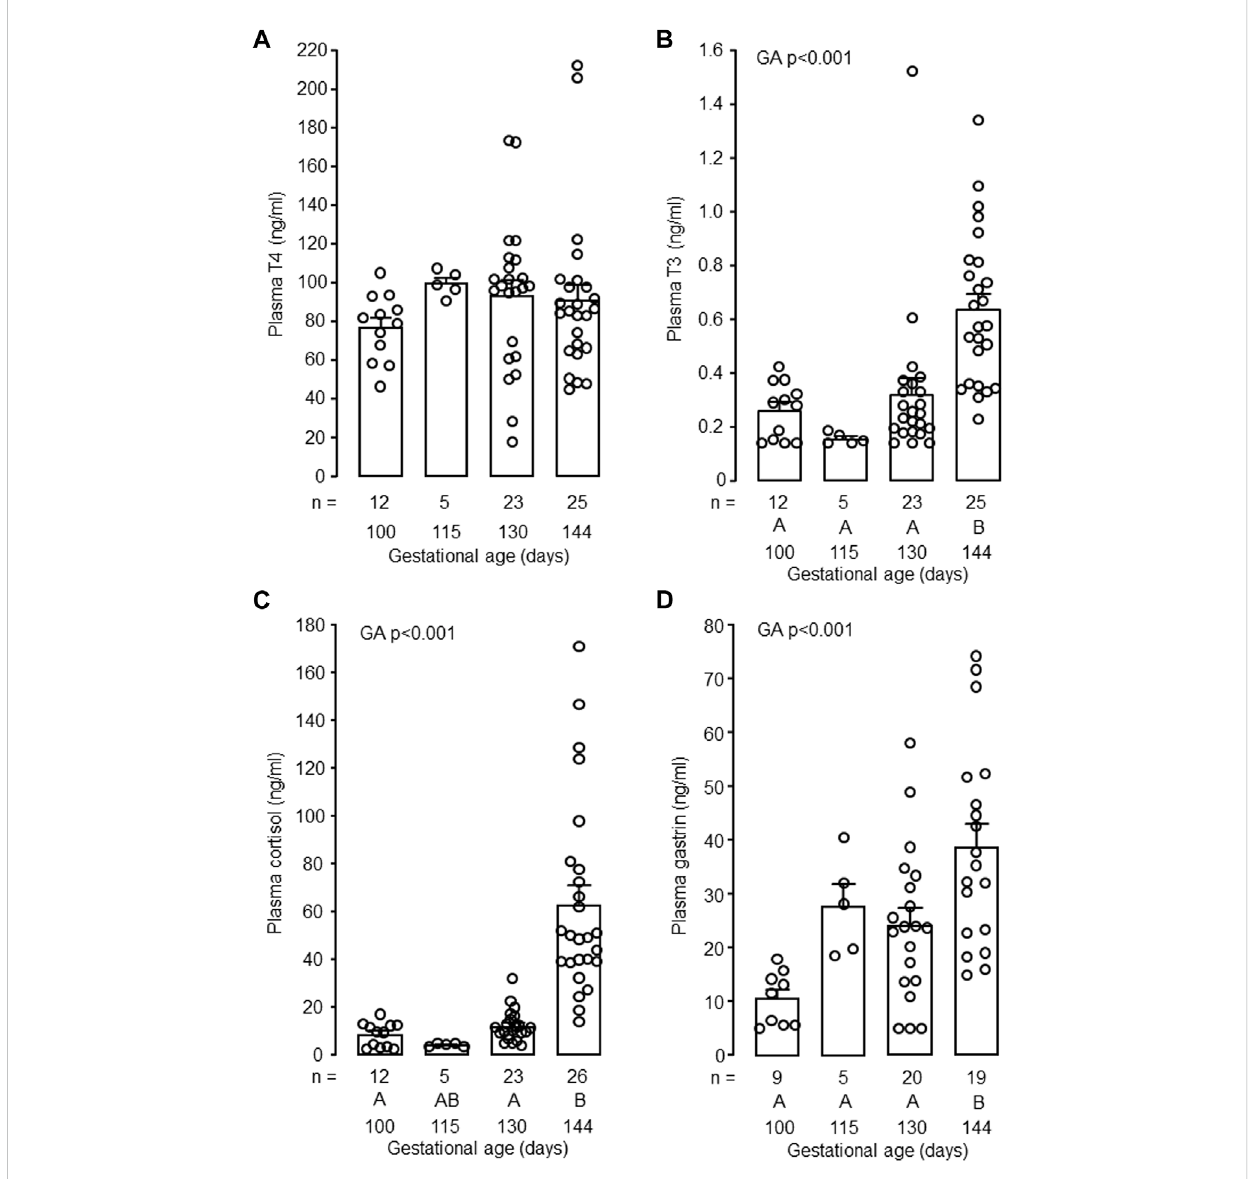
FIGURE 2 Mean (±SEM) and individual plasma concentrations of (A) thyroxine (T4), (B) triiodothyronine (T3), (C) cortisol and (D) gastrin in the intact fetuses studied between 100 and 144 days of gestation. For each parameter measured, values with different letters at the base of the histogram are signi fi cantly different from each other ( p < 0.05, one-way ANOVA). Numbers of fetuses in each group are indicated at the base of the histogram. GA, gestational